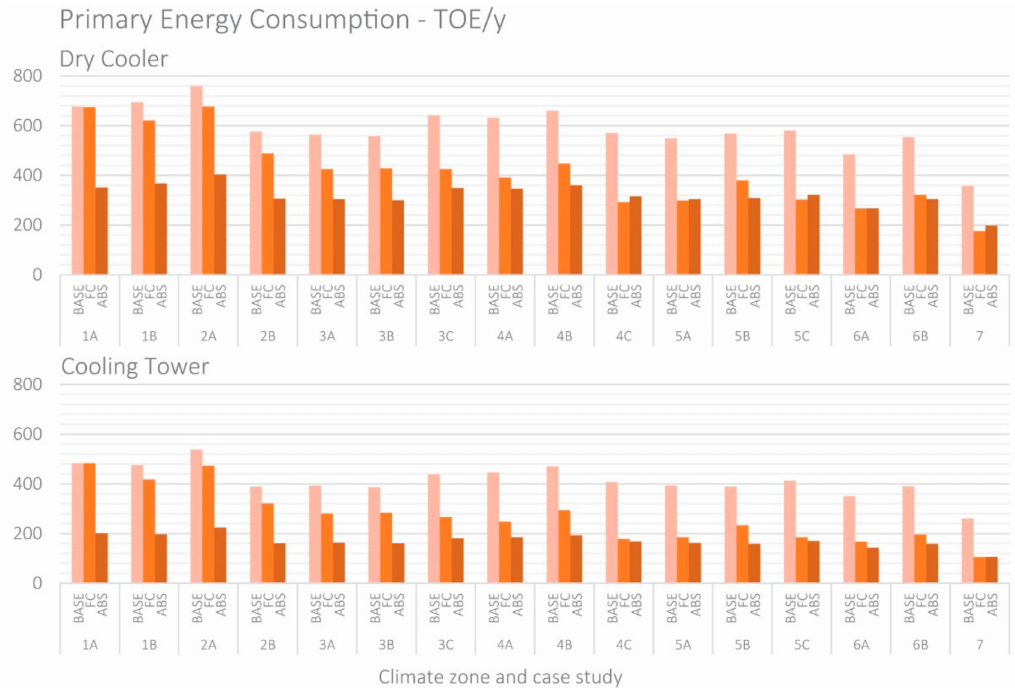
Figure 9. Primary energy (PE) consumption based on climate zone and case